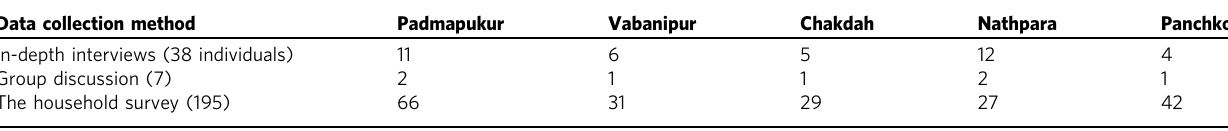
Table 2 Empirical data across